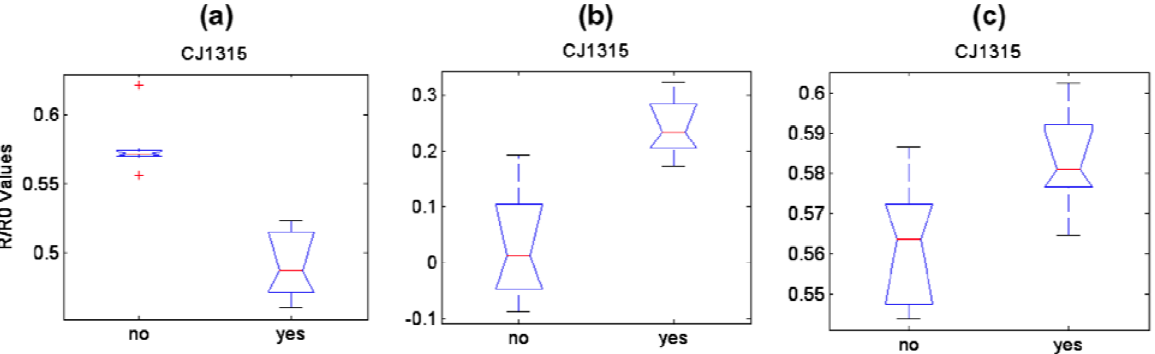
Figure 11. Box plots of sensors able to identify ACB contaminated (“yes”) and uncontaminated (“no”) juice samples. Feature considered is R/R ( b ) orange; ( c ) apple. Reprinted from [46] with permission from Elsevier, Copyright